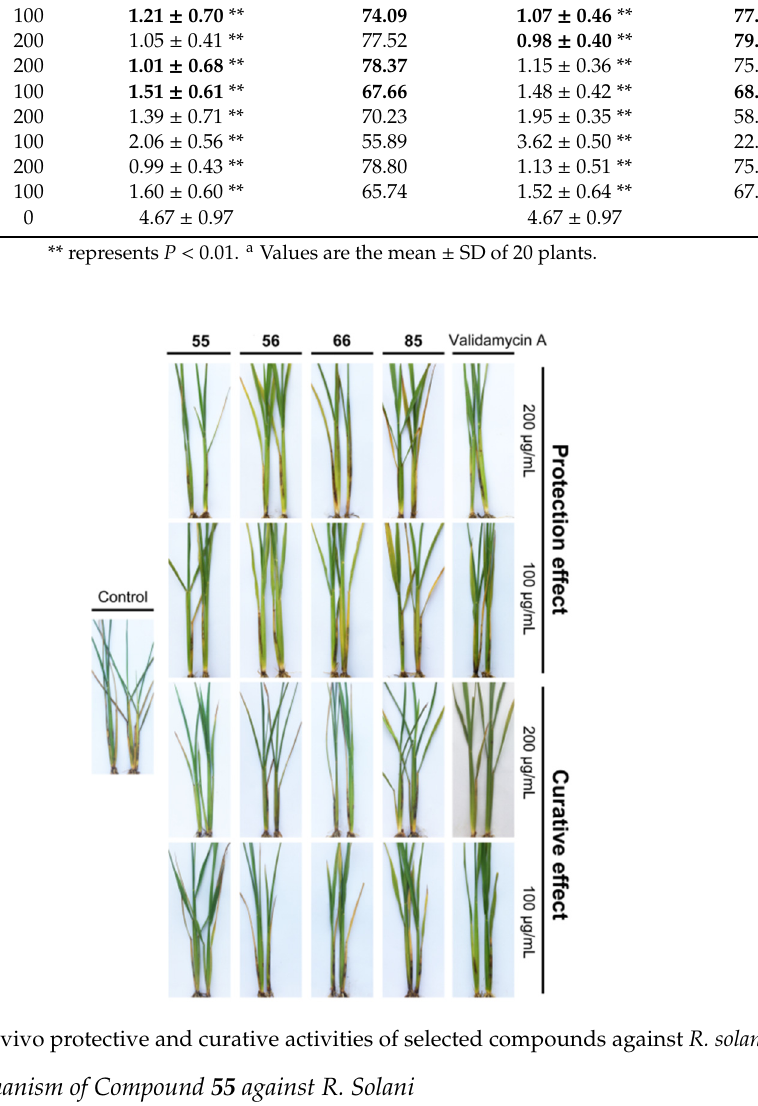
Figure 4. In vivo protective and curative activities of selected compounds against R. solani.